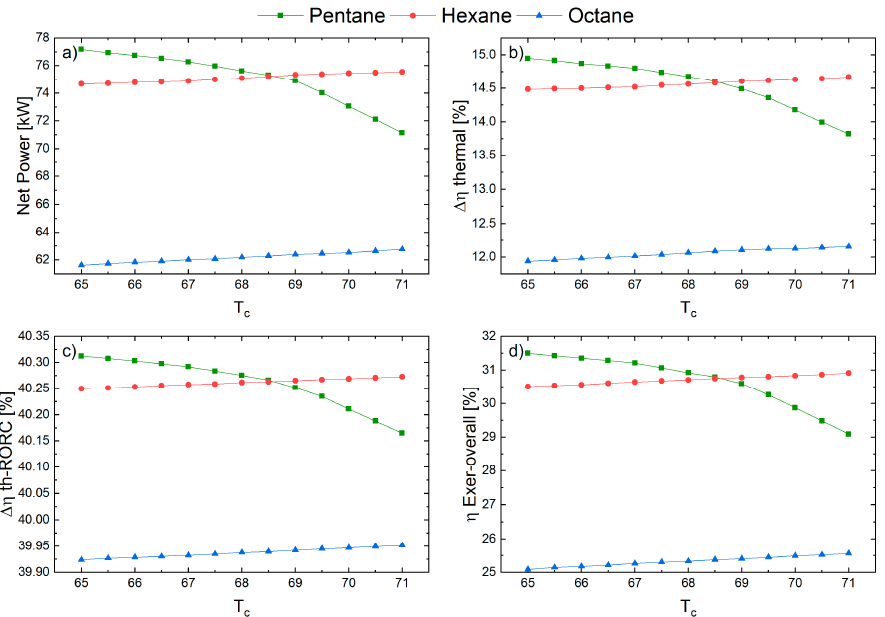
Figure 8. Performance of di ff erent fluids for a RORC system with varying condensing temperature. ( a ) Net power; ( b ) Increase in thermal e ffi ciency; ( c ) RORC thermal e ffi ciency; and ( d ) Global exergetic e ffi